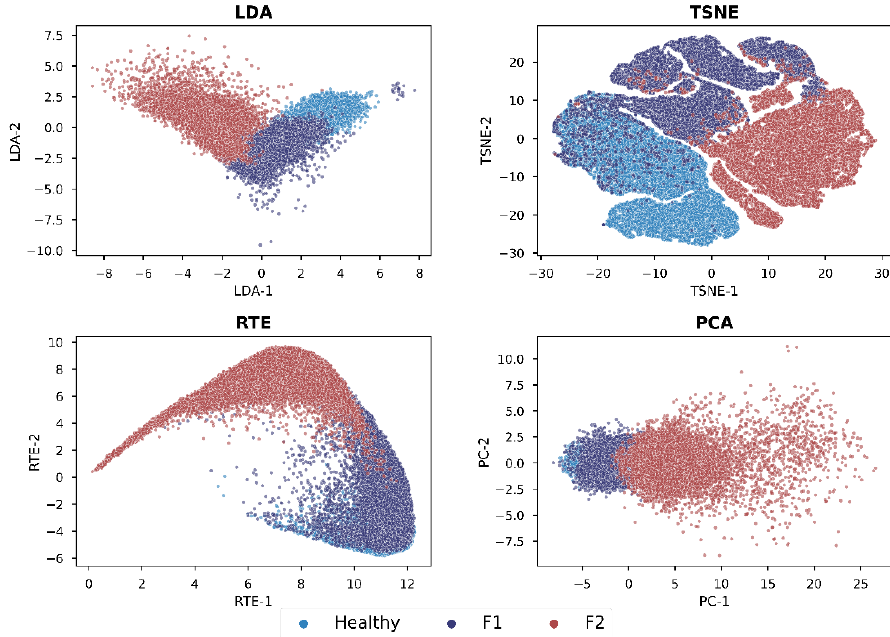
Figure 10. Reduced feature space using different algorithms.